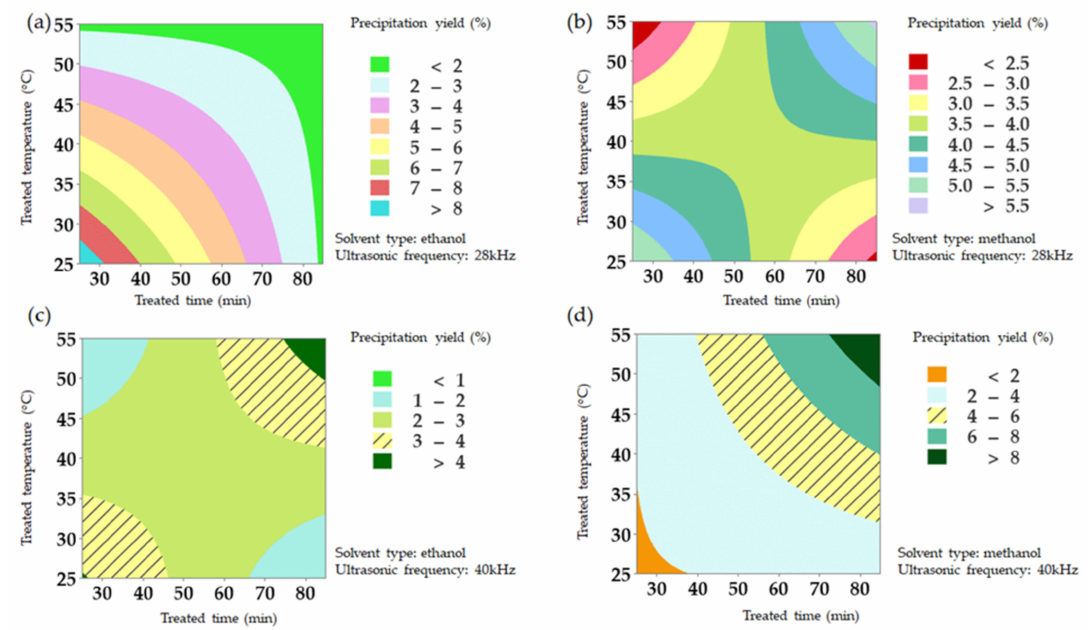
Figure 2. Contour plot for the effect of treated time and treated temperature on precipitation yield under different solvent types [( a , c ): ethanol; ( b , d ): methanol] and ultrasonic frequencies [( a , b ): 28 kHz; ( c , d ): 40